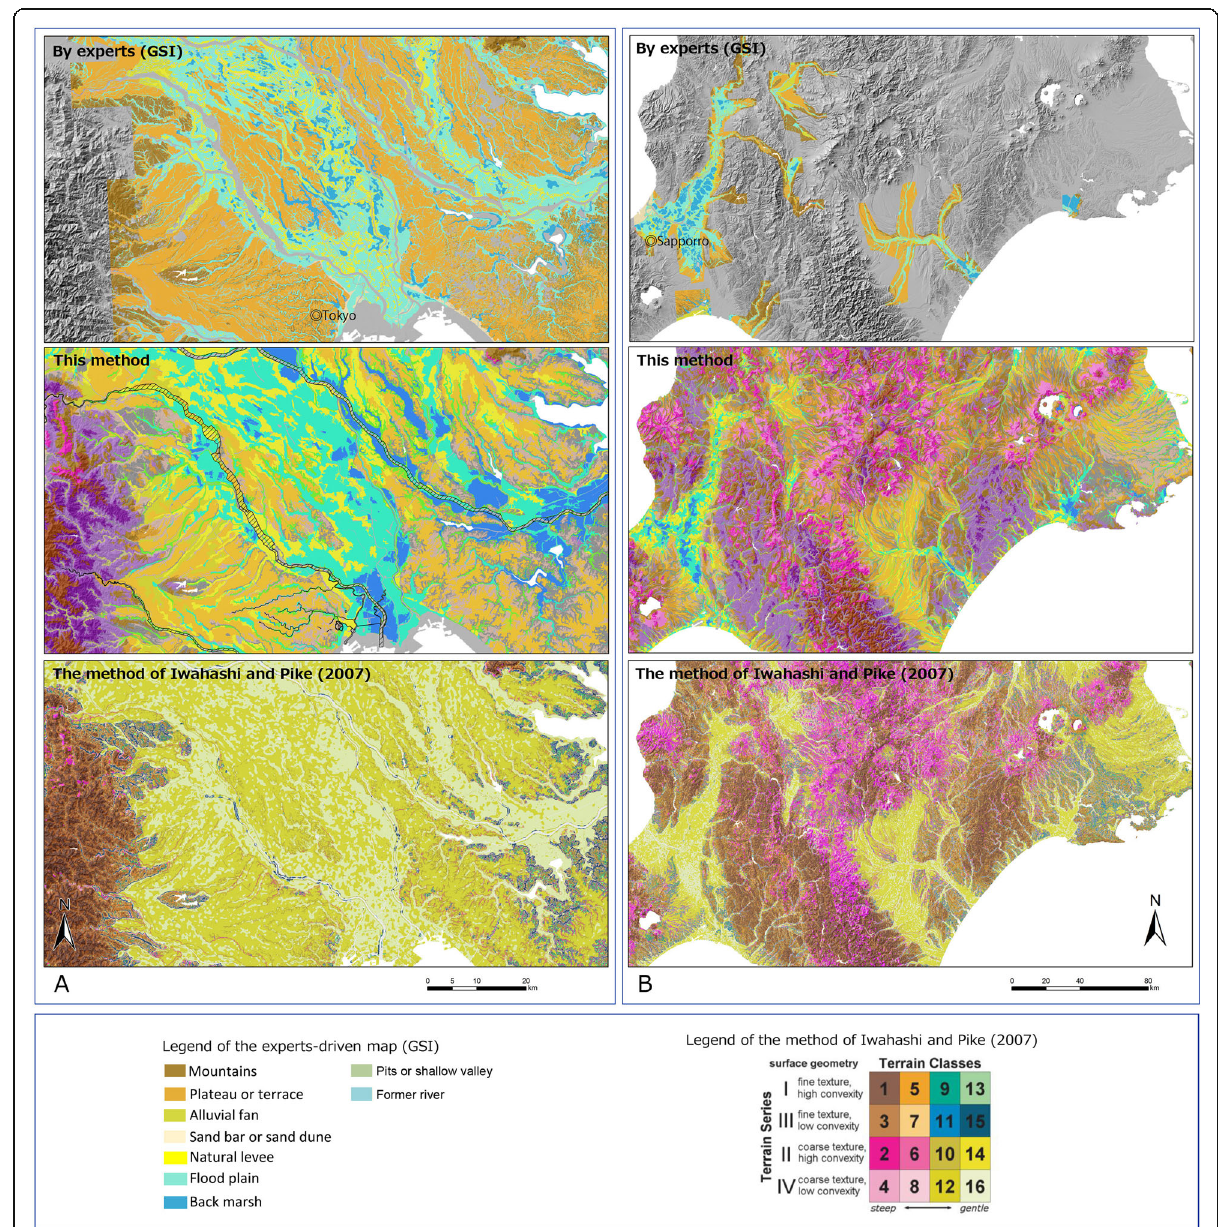
Fig. 15 Comparison of the terrain classification of this study with other classifications. Legend of the current classification is the same as in Fig. 14. Location maps are included in Fig. 14. a The capital area, in comparison with the terrain classification by the method of Iwahashi and Pike (2007) and the expert-driven maps (the landform classification in Table 2; the legends are aggregated). Oblique lines in the terrain classification show the riverbeds. b Hokkaido, a similar set as